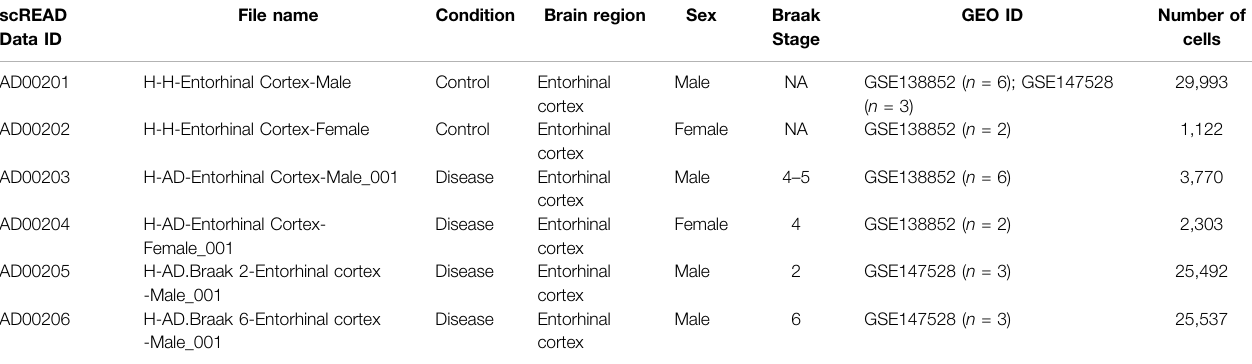
TABLE 1 | Information on the snRNASeq datasets obtained from scREAD database for NGKD analysis (Human)*. scREAD Data